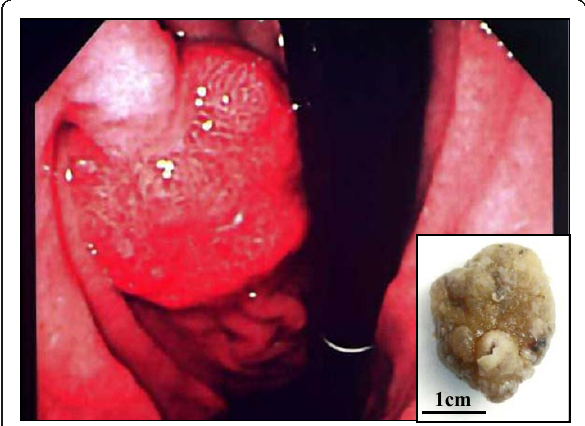
Figure 1 Endoscopic and gross examination of the polyp . Gastrointestinal endoscopy shows a solitary pedunculated polyp lesion, classified as Yamada type IV, in the posterior wall of lower gastric body. On gross finding of the resected specimen (inset), the surface of this polyp, measuring 26 × 20 × 20 mm, reveals focally irregular features with erosion and